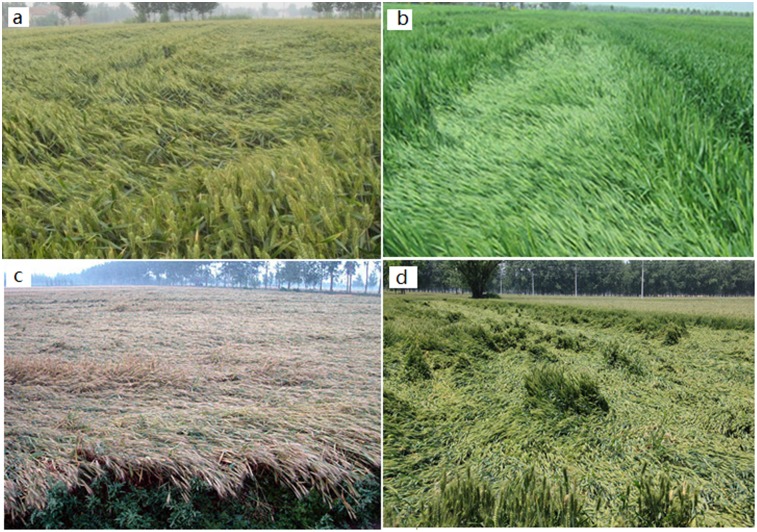
Lodging due to strong wind.a. Lijin county, Shandong (05/25/2012). b. Jingzhou city, Hubei (04/05/2013). c. Tancheng county, Shandong (05/28/2007). d. Lingbi county, Anhui (05/16/2012).